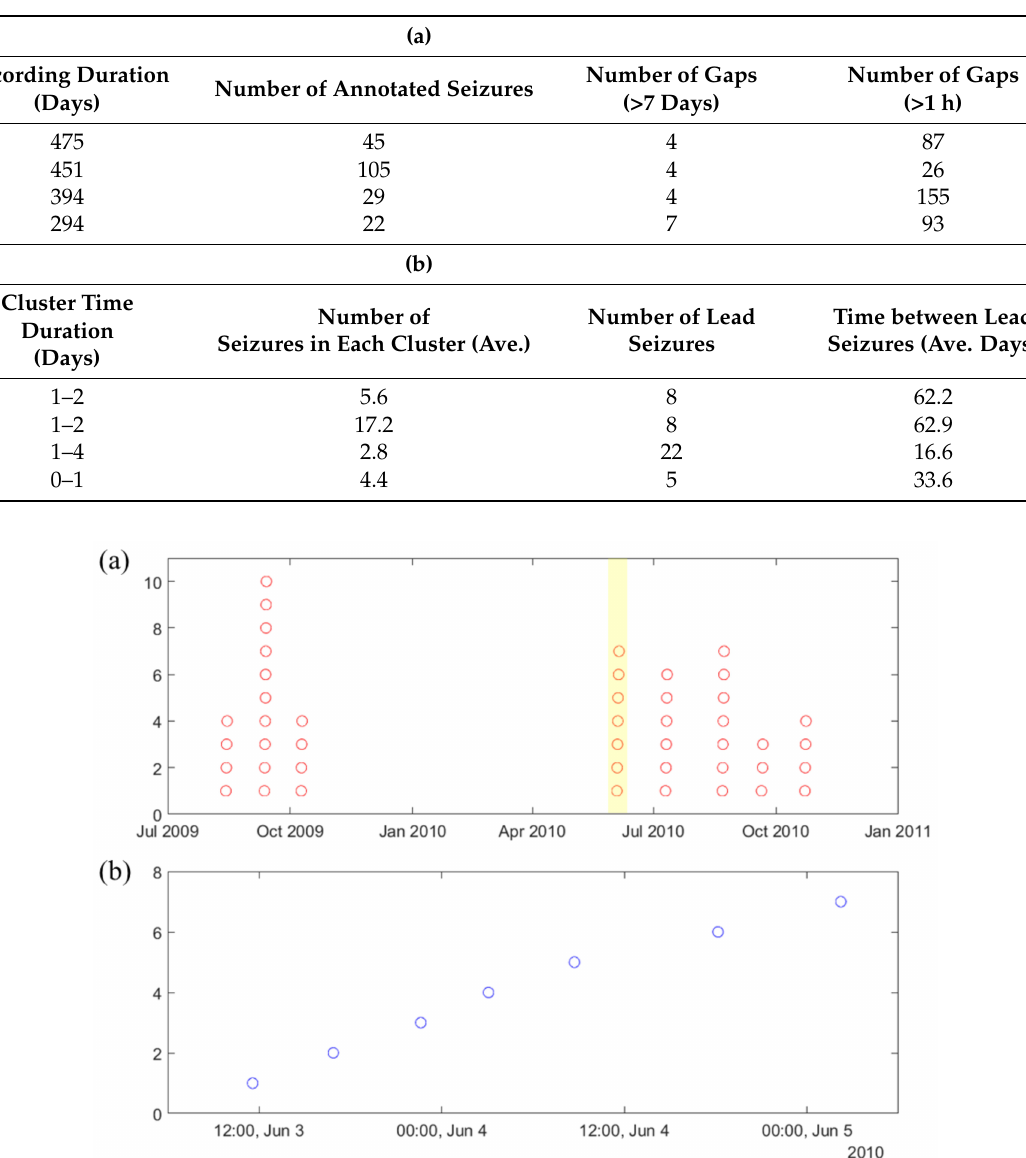
Table 1. ( a ) Summary of iEEG recordings. ( b ) Summary of seizure clusters.